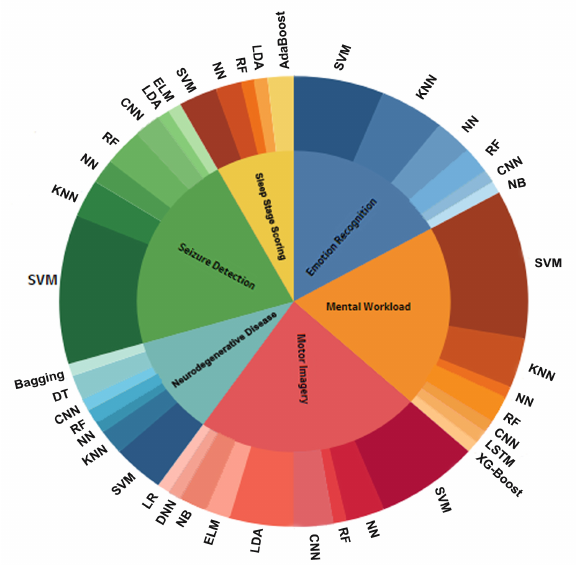
Figure 8. The most efficient machine learning algorithms used for different tasks. The inner circle represents the type of tasks, and the outer circle represents the utilization rate of the supervised machine learning and deep learning classification algorithms used for each task across all studies evaluated. Abbreviations: CNN, convolutional neural network; DNN, deep neural network; DT, decision tree; ELM, extreme learning machine; KNN, K-nearest neighbor; LDA, linear discriminant analysis; LR, logistic regression; LSTM, long short-term memory; NB, naïve Bayes; NN, neural networks; RF, random forest; SVM, support vector machine.